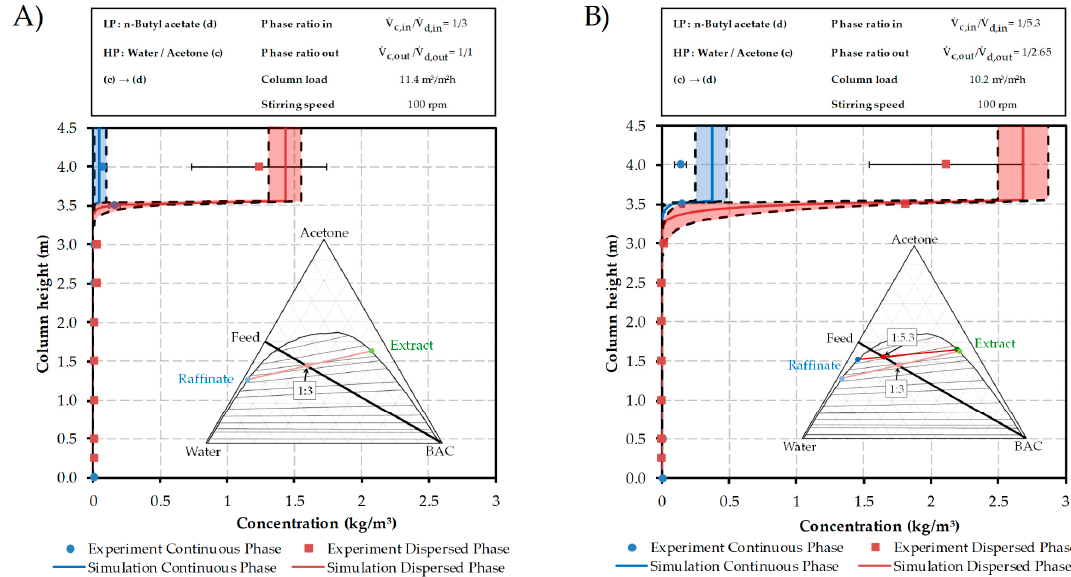
Figure 8. Comparison of experimental and simulated column profiles. Center-point is shown on the left side ( A ), the optimized operating point is shown on the right hand side ( B ). The enveloped curves represent the minimum and maximum values of 100 Monte-Carlo simulation runs. Also shown are the phase diagrams including mixing point, extract and raffinate composition for each operating point. Table 4. Axial dispersion model parameters for the center point study. The default values of the simulation equal the experimental process parameters.